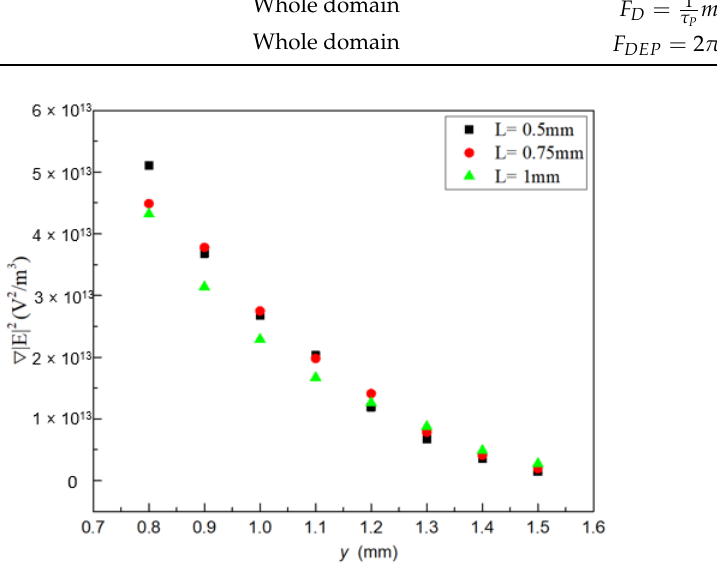
Figure A1. Dependence of the ∇ | E | 2 on height for three D = 1 mm electrode arrays with different spacing L .